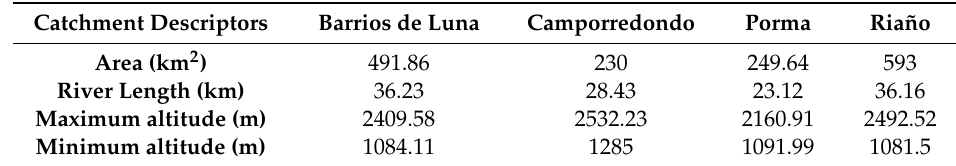
Table 1. Catchment